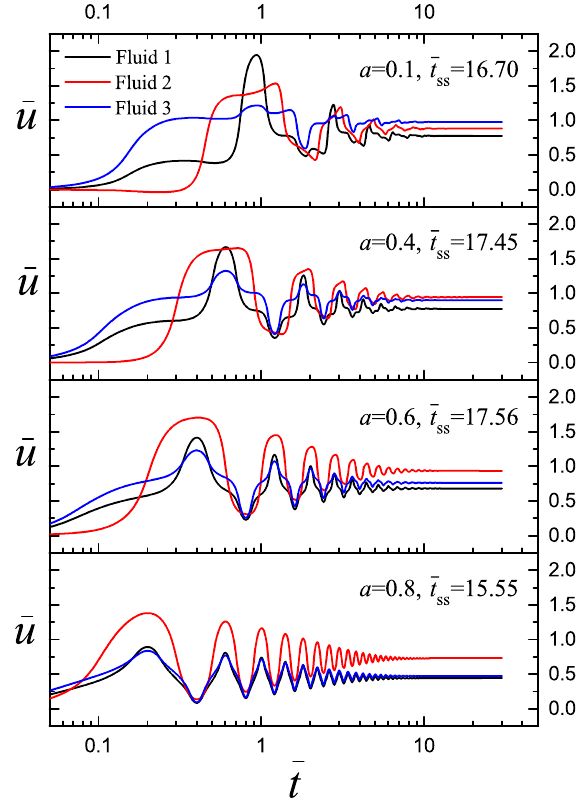
Figure 11. Velocity tracking of an electro-osmotic flow with n = 3, Γ = 0, ¯ κ n = 20, ∆ ¯ ψ n = 0.25, ¯ ρ n = ¯ (cid:101) n = ¯ λ n = ¯ η n = ¯ ζ I,O = 1, for different values of internal radius a = (0.1, 0.4, 0.6, 0.8) with equidistant interface